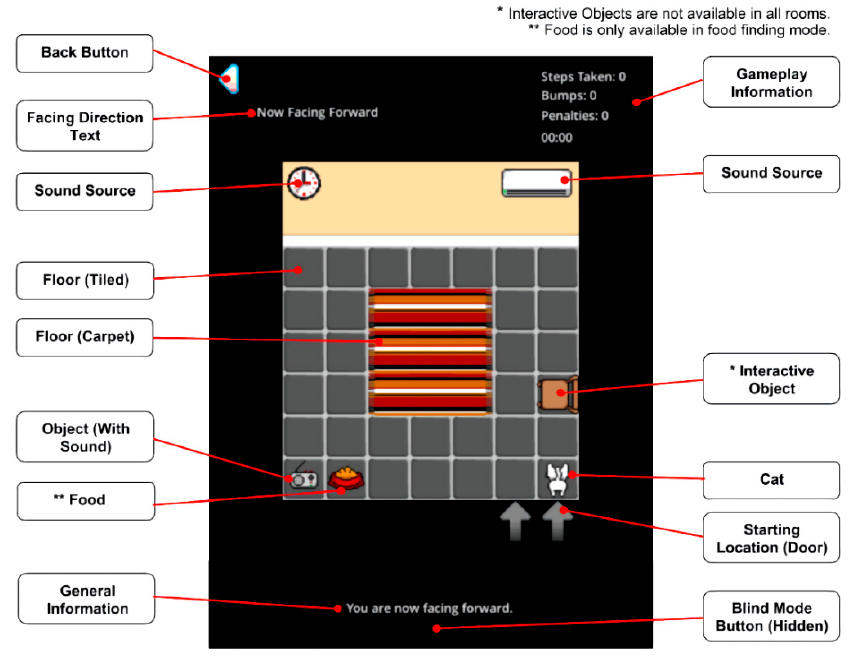
Figure 2. General layout for one of the rooms.